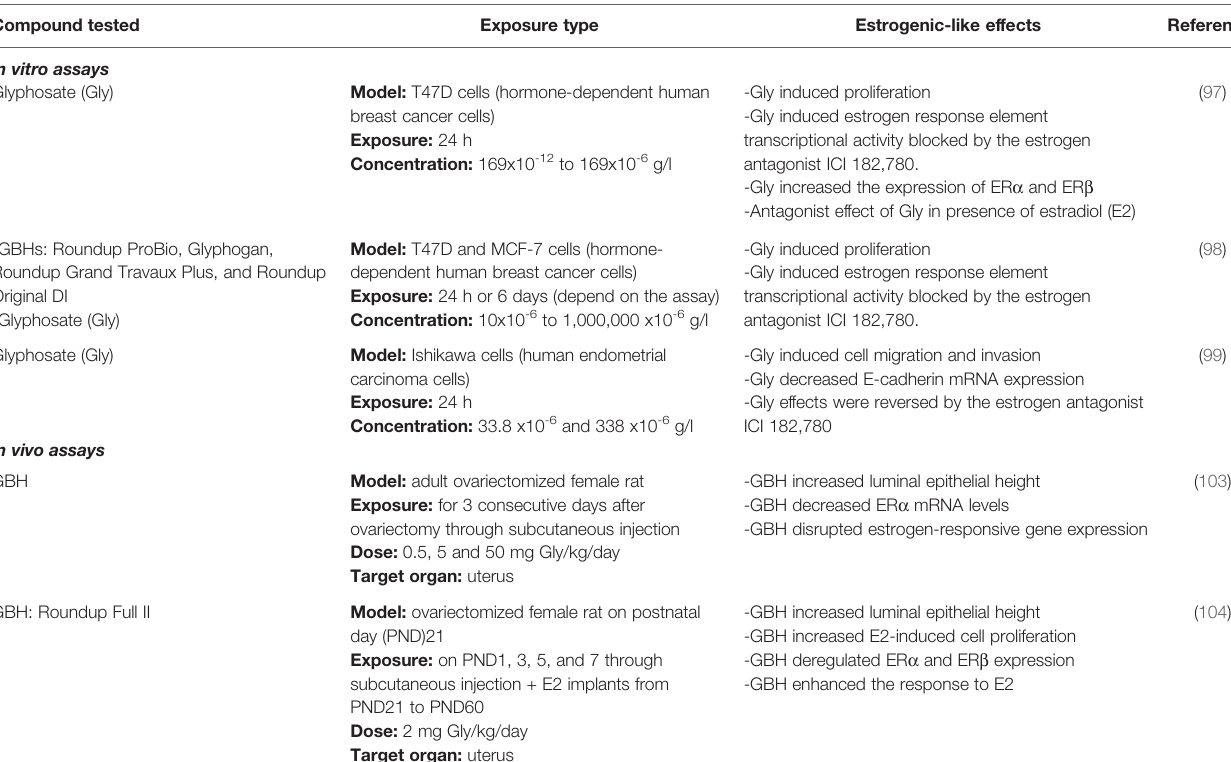
TABLE 3 | In vitro and in vivo assays showing estrogenic-like properties of glyphosate (Gly) and glyphosate-based herbicides (GBHs). Compound